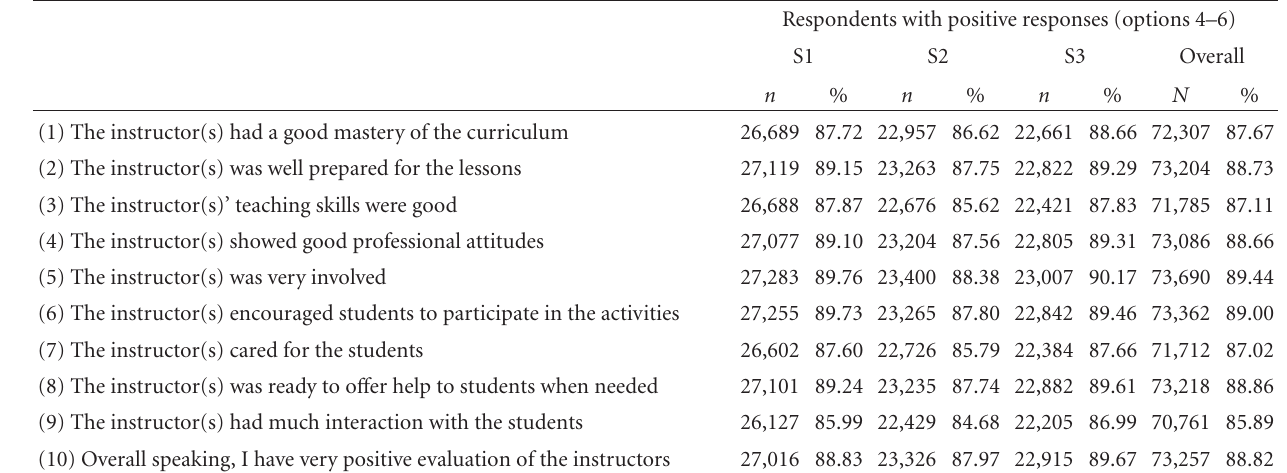
Table 2: Summary of the program participants’ perceptions toward the program implementers.